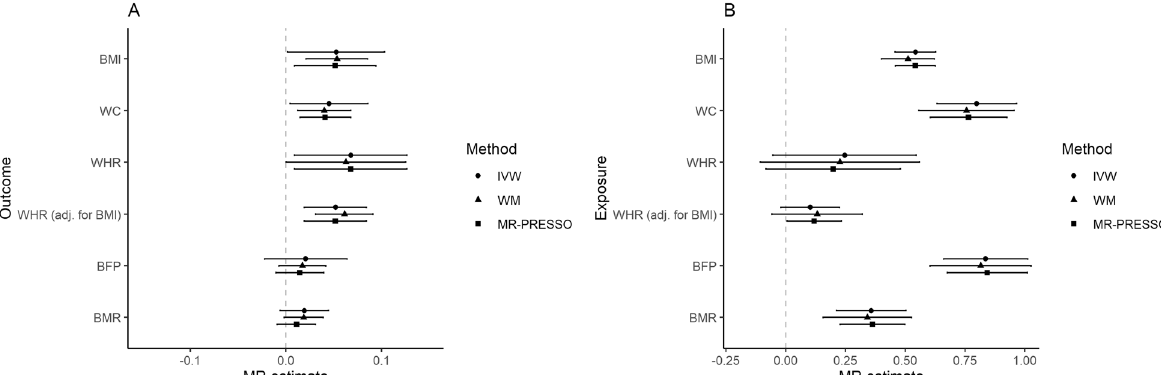
Fig. 2 Forest plot of MR estimates and their 95% con fi dence intervals for the effect of ADHD liability on obesity-related traits (left panel), and for the effect of obesity-related traits on ADHD (right panel). BMI body mass index, WC waist circumference, WHR waist-hip-ratio, BFP